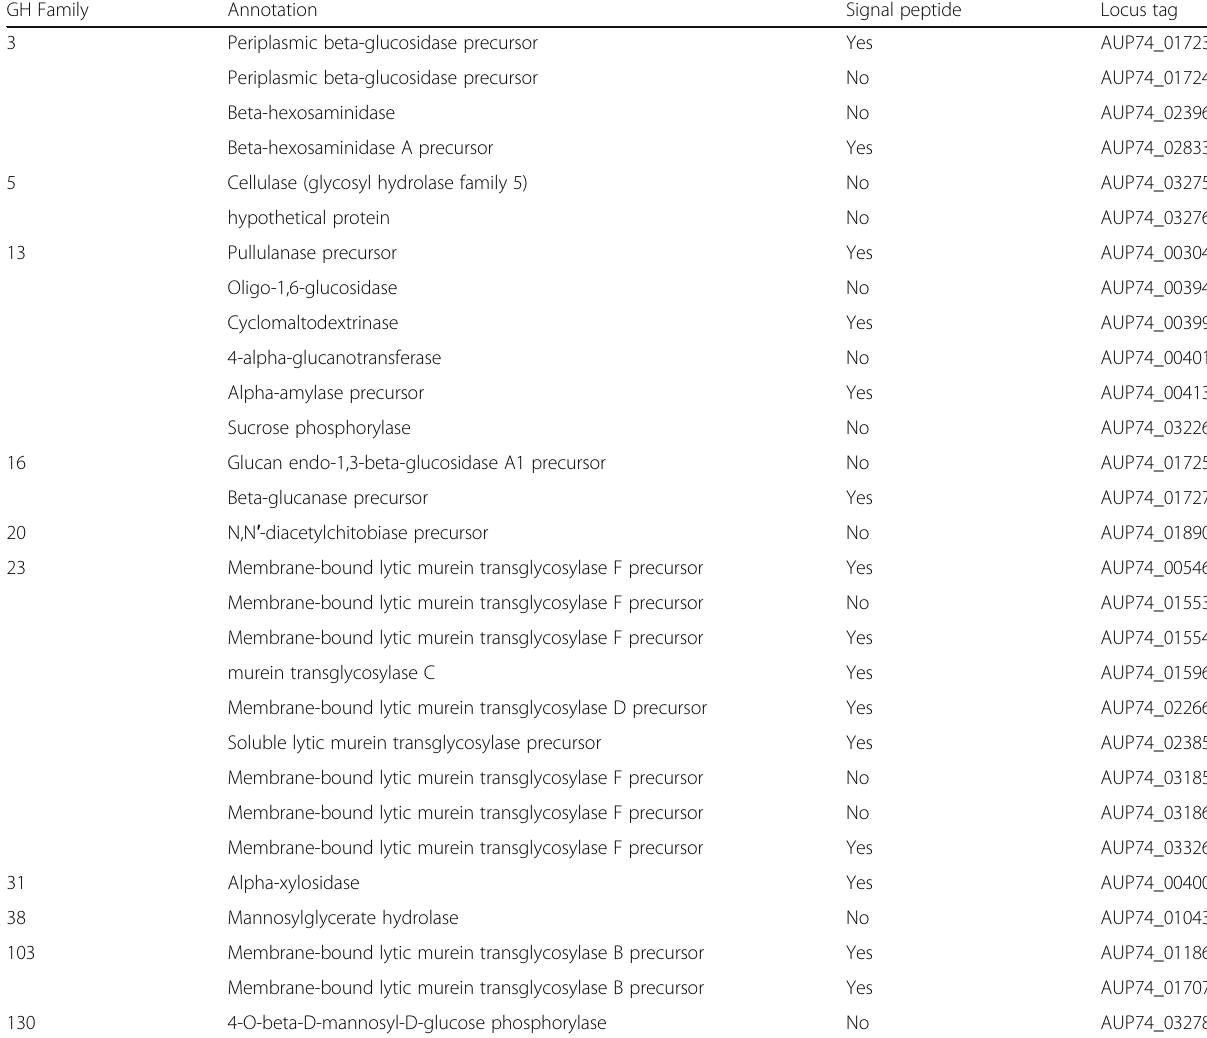
Table 6 GH enzyme coding genes found in CCB-MM1 genome GH Family